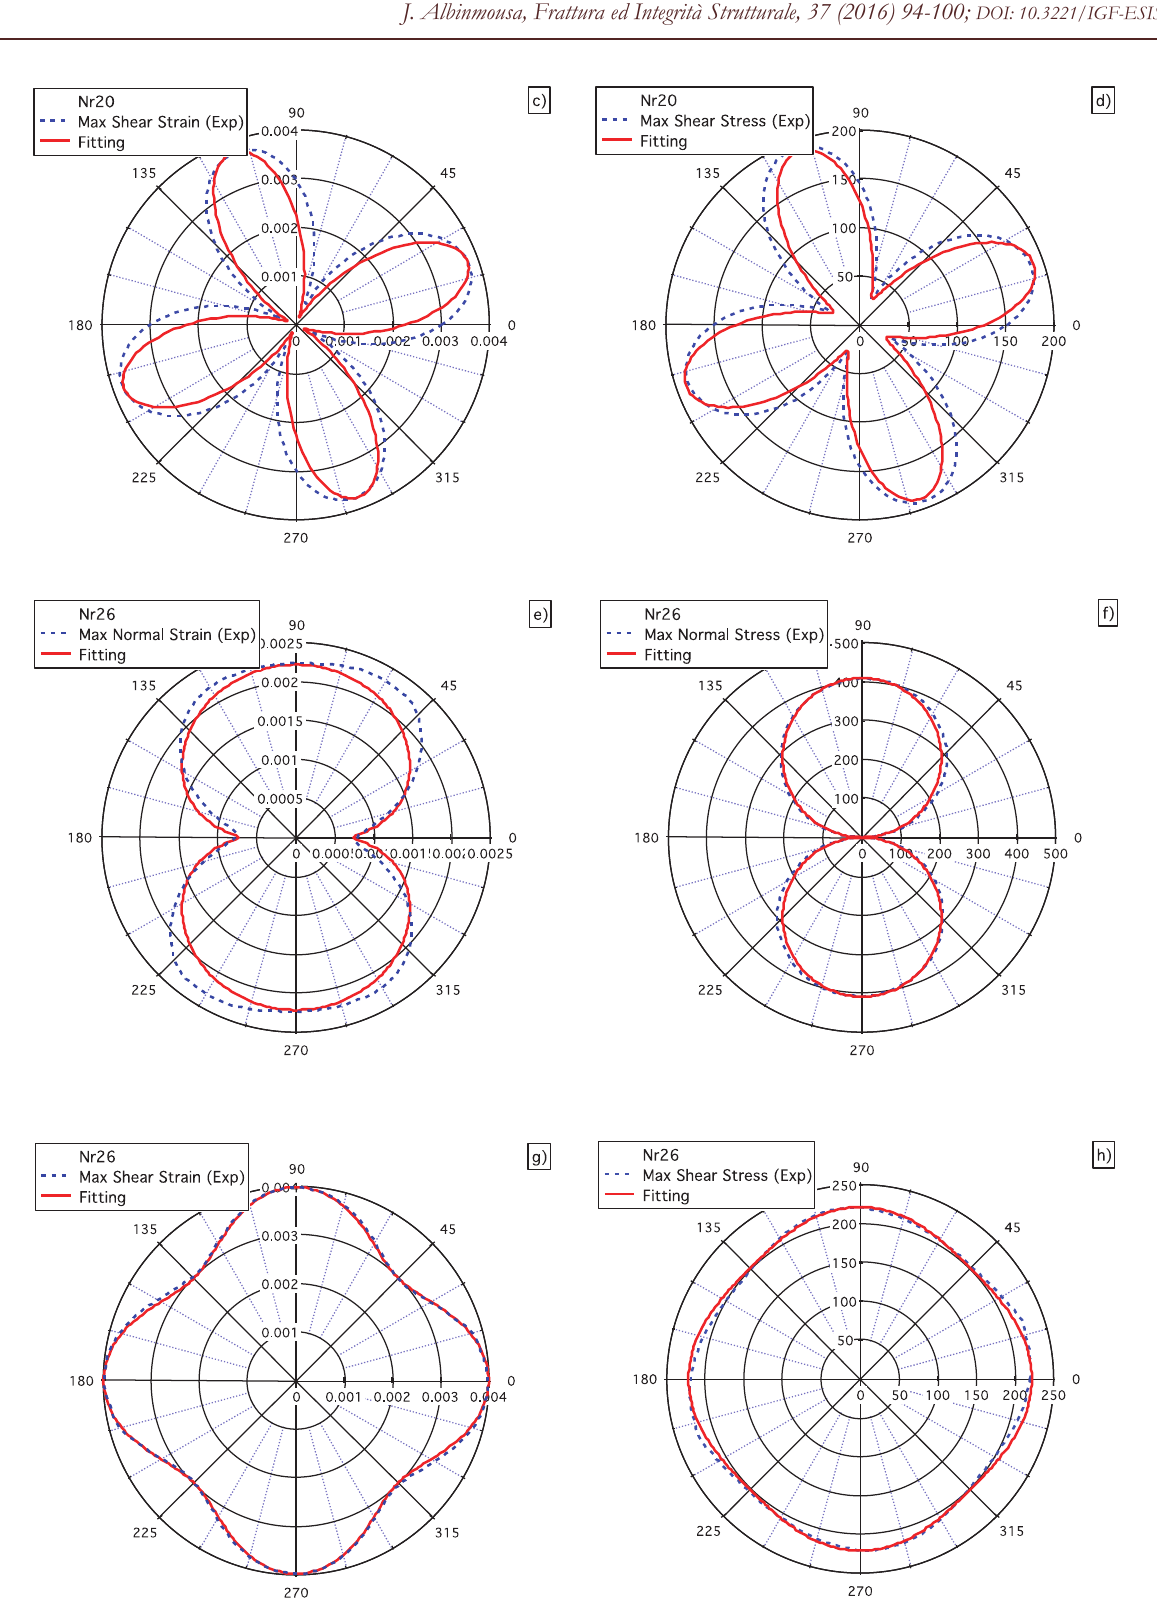
Figure 2: Parametric representation and fitting of the stress and strain responses for the proportional and nonproportional loading cases Nr20 and